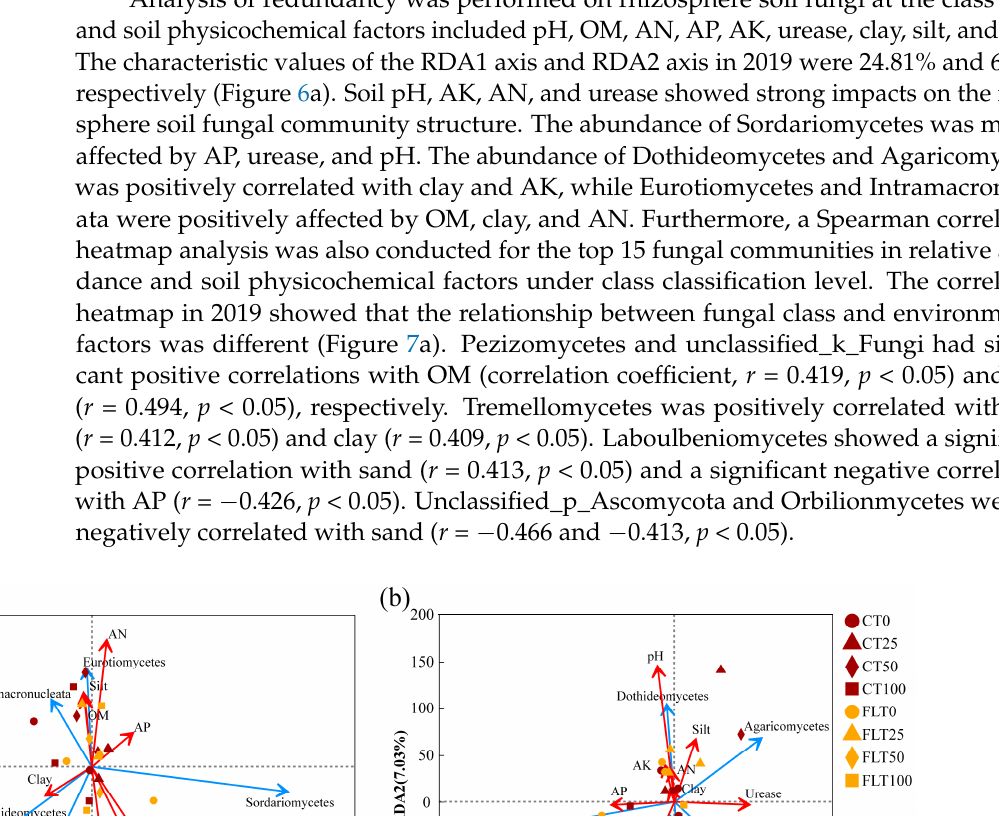
Figure 7. Correlation heatmaps between the fungal community at the class level and the physico- chemical properties of cassava rhizosphere soil collected in 2019 ( a ) and 2020 ( b ), respectively. OM, organic matter; AN, available nitrogen; AP, available phosphorus; AK, available potassium. * p < 0.05, ** p < 0.01. In 2020, the first two components of RDA explained 23.84% of the total variance (Fig- ure 6b). The 0% N and the 25% N treatments were also separated from the 50% N and the 100% N treatments within the FLT group by the second axis (7.05%). The abundance of Sordariomycetes was mainly affected by AP and OM, while Eurotiomycetes was posi- tively correlated with urease within the higher N application rate group. The abundance of Agaricomycetes was positively correlated with silt and urease. The abundance of Dothideomycetes was closely related to clay, silt, AN, AK, and pH. In addition, the corre- lation heatmap in 2020 revealed that Saccharomycetes showed a significantly positive cor- relation with urease ( r = 0.530, p < 0.01) (Figure 7b). Unclassified_p_Ascomycota and Dothideomycetes were all positively correlated with pH ( r = 0.473 and 0.426, p < 0.05). Glomeromycetes was significantly positively correlated with AP ( r = 0.492, p < 0.05). In- tramacronucleata showed a negative correlation with AN ( r = − 0.470, p < 0.05).